Question: Draft a figure caption describing what is shown.
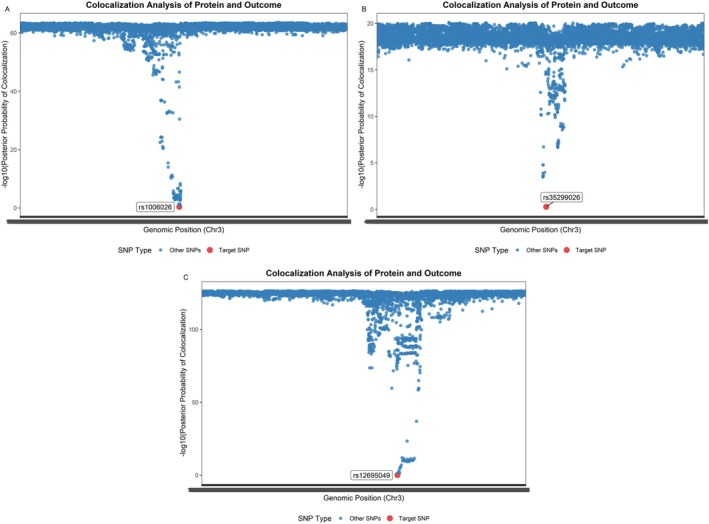
Answer: Visualization of 3 plasma proteins co‐localization results. A: Regional association plot of CD30 ligand protein (TNFSF8) with OC risk. Dominant SNPs are shown as red dot. SNPs within ±1 MB of the protein quantitative trait locus are included. (B) Regional association plot of DHB14 protein (HSD17B14) with OC risk. Dominant SNPs are shown as red dot. SNPs within ±1 MB of the protein quantitative trait locus were included. (C) Regional association plot of XXLT1 protein (XXYLT1) with oral cancer risk. Dominant SNPs are shown as red dot. SNPs within ±1 MB of the protein quantitative trait locus were included.